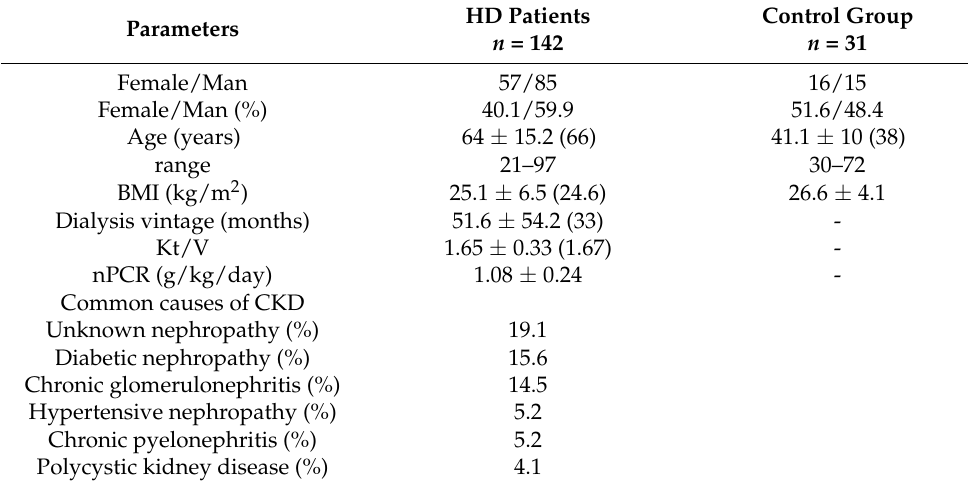
Table 1. Characteristics of the study populations.